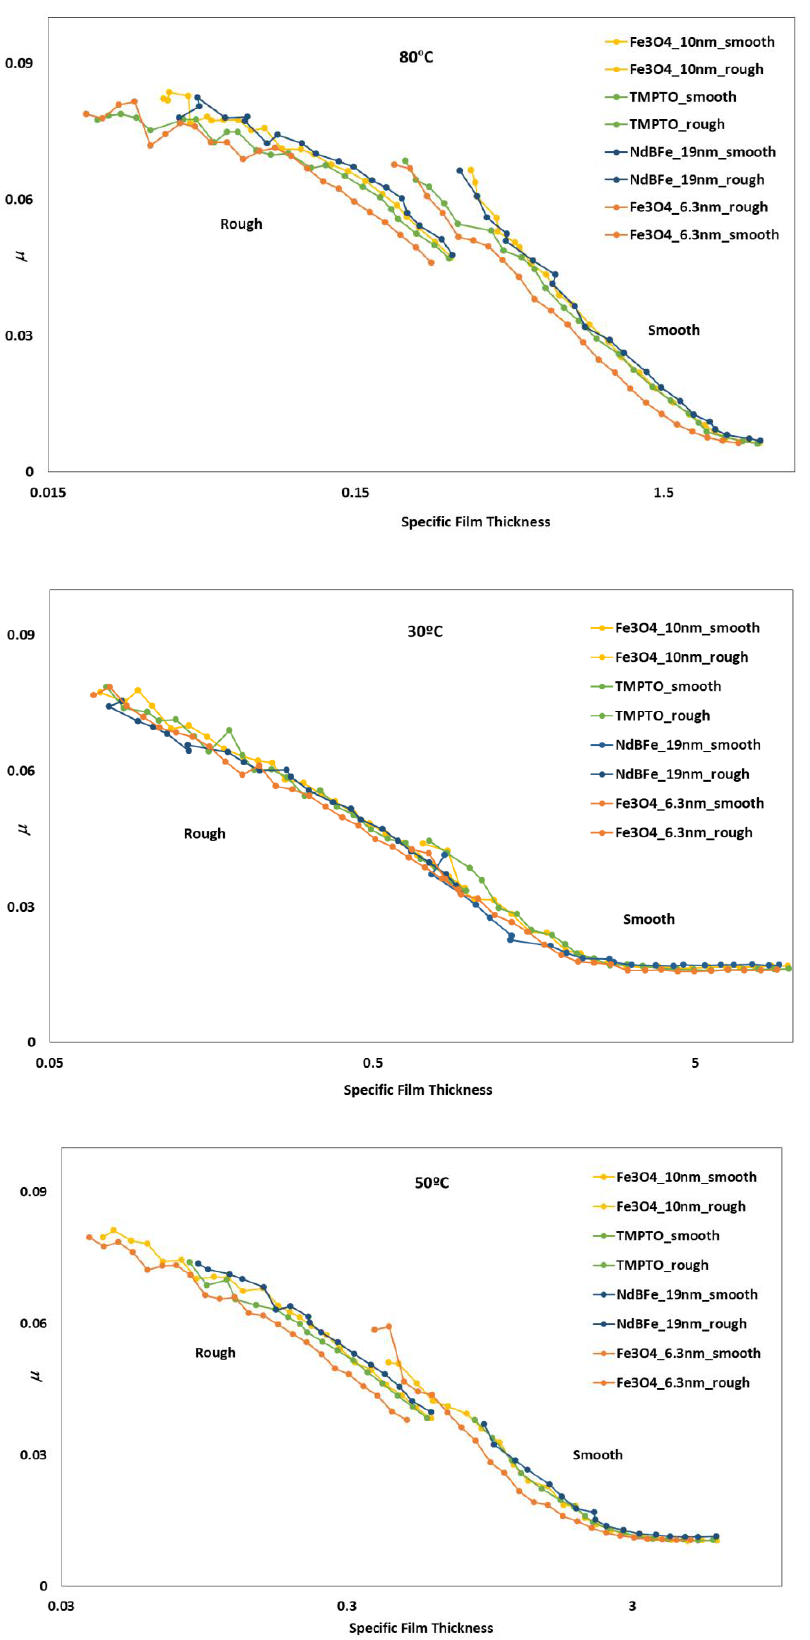
Figure 16. Stribeck curves of the base oil and dispersions with magnetic nanoparticles tested for rough and polished discs at 5% SRR.